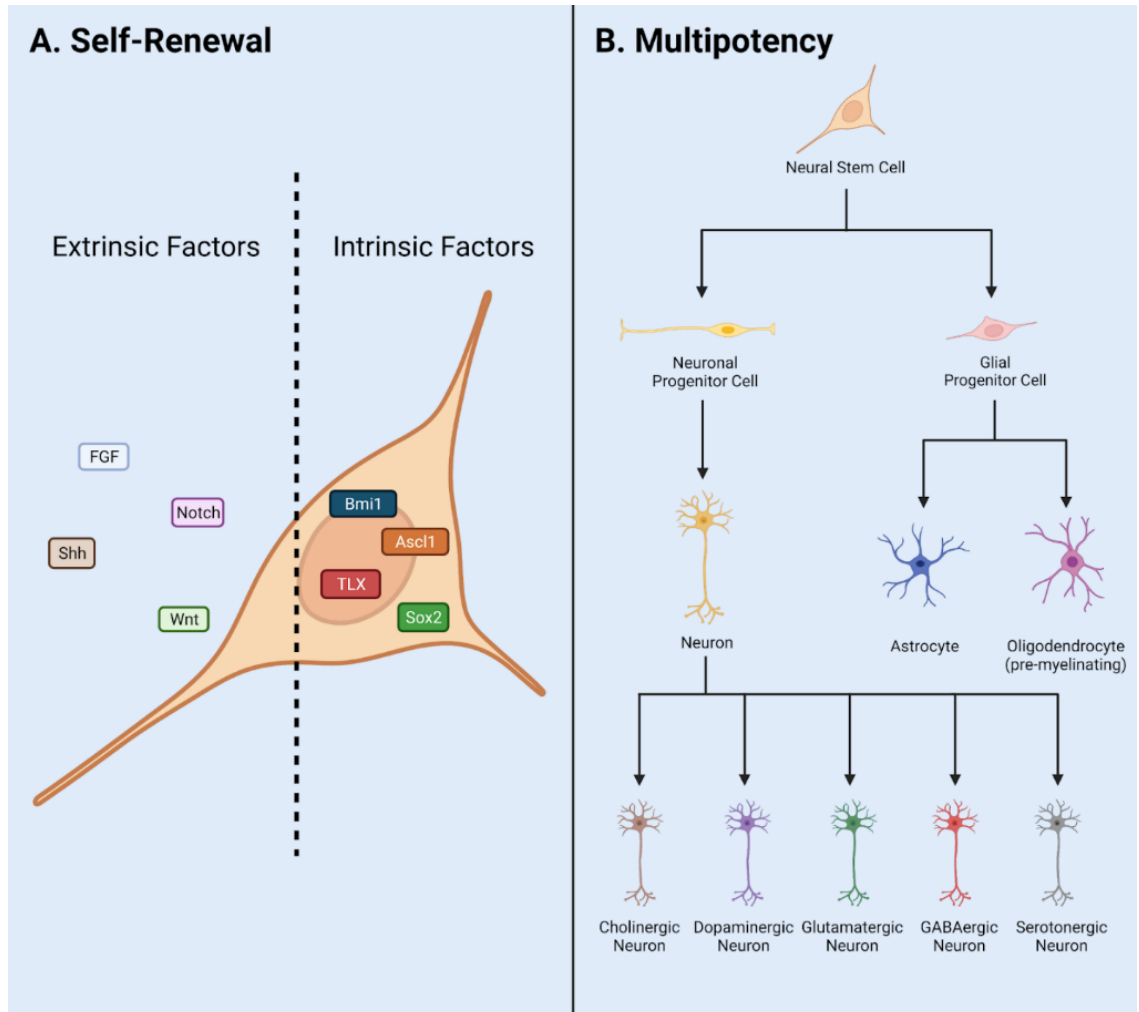
Figure 1. NSPC characteristics in adult mammals. ( A ) Self renewal requires input via extrinsic and intrinsic factors. These include signaling pathways Notch, Wnt, and Shh, and transcription factors Sox2, Ascl1, Bmi1, Tlx, and neurotransmitters and neurotrophic/trophic growth factors. ( B ) Multipotency allows NSPCs to differentiate into a variety of cell fates such as Neurons, Astrocytes, and Oligodendrocytes. Adapted from Navarro Quiroz et al., 2018 [6] .